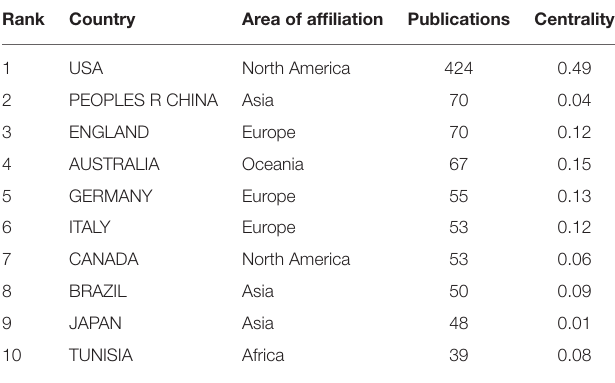
TABLE 1 | Top 10 countries (regions) in terms of number of publications in the field of intermittent fasting research. Rank